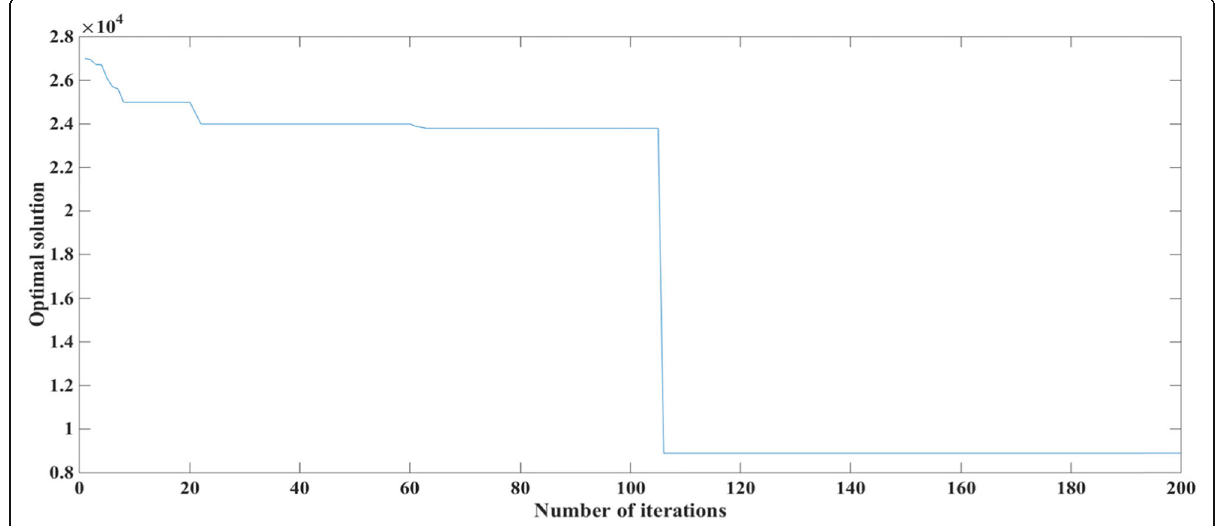
Fig. 6 Genetic algorithm optimization